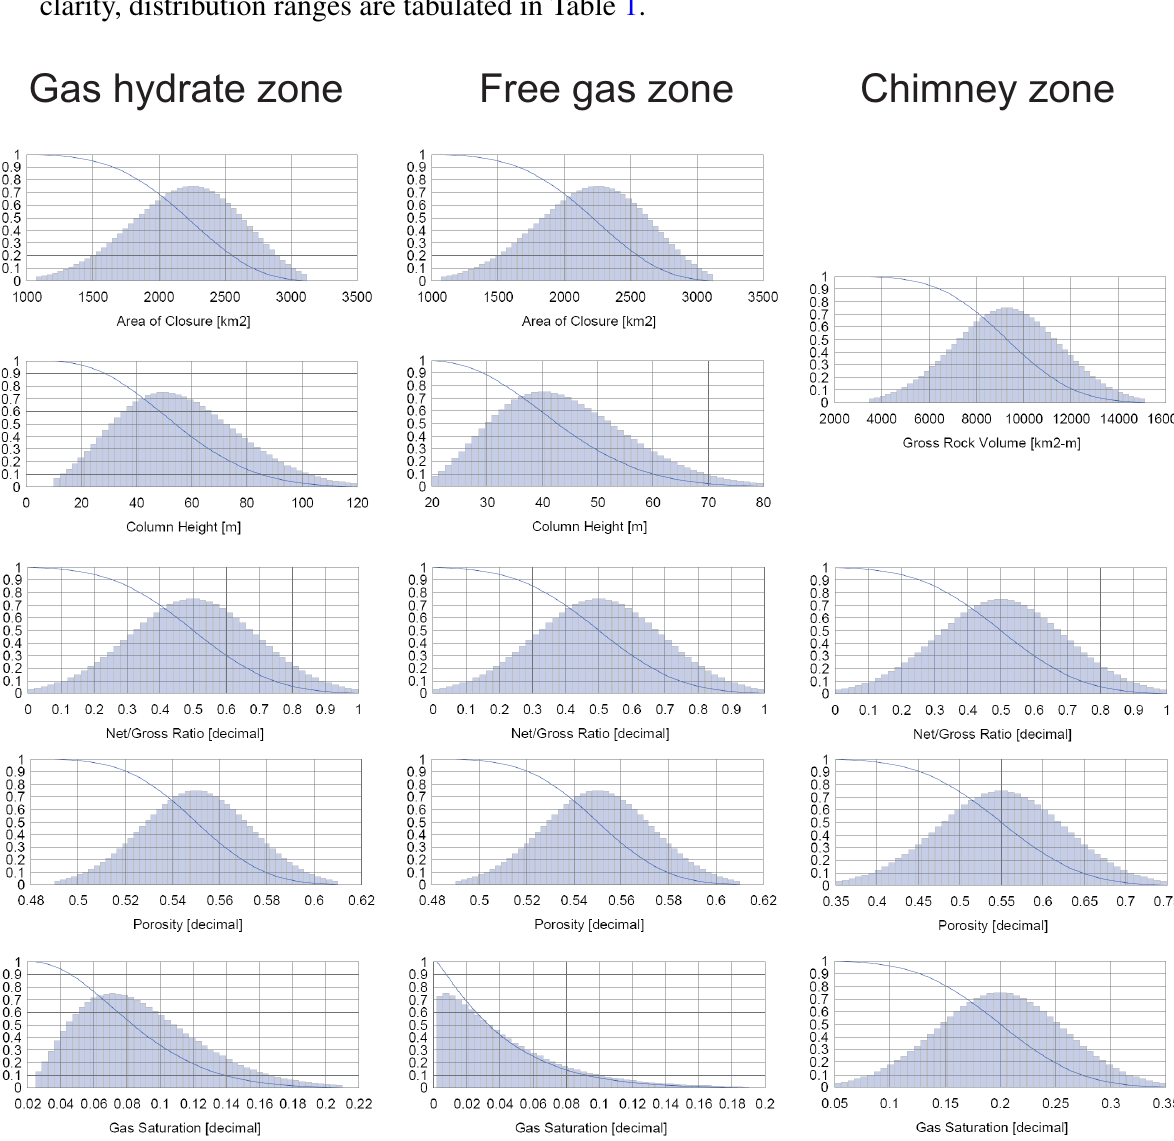
Figure 7. A graphical representation of the distributions of the various reservoir parameters for Nyegga’s three segments. The graphs illustrate the relative probability of a particular value to be chosen for the stochastic volumetric